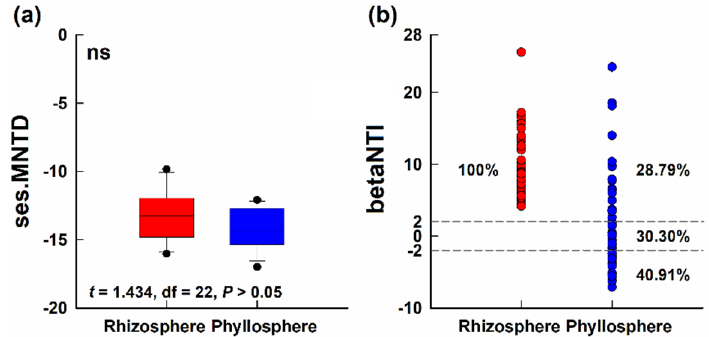
Figure 5. Phylogenetic structure of bacterial communities associated with rhizosphere and phyllosphere of Phragmitas australis based on null model analysis. ( a ) Comparisons of the standardized effect size of the mean nearest taxon distance (ses.MNTD). The top and bottom boundaries of each box indicate the third and first quartile values, respectively, and lines within each